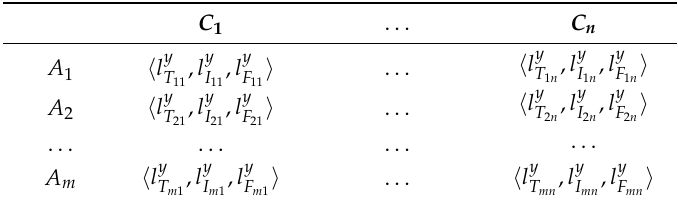
Table 1. The neutrosophic linguistic decision matrix R y of the expert E y . C